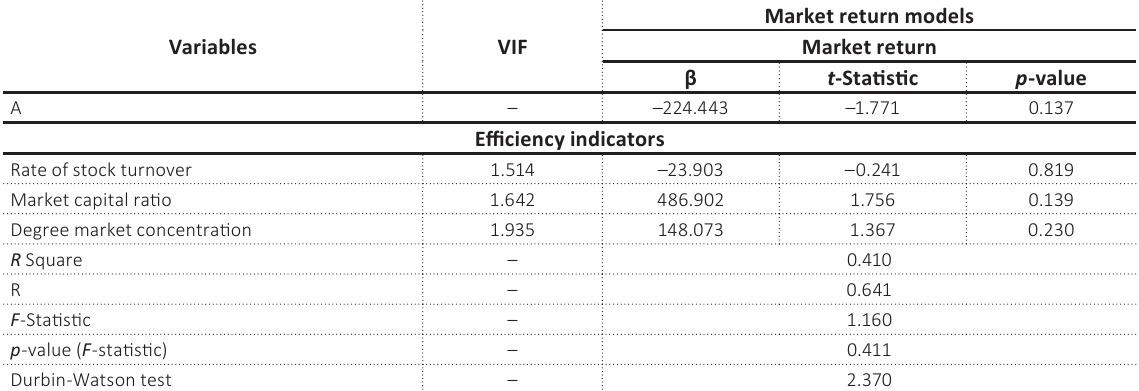
Figure 3. Market capital ratio Figure 4. Degree of market Table 4. Regression results